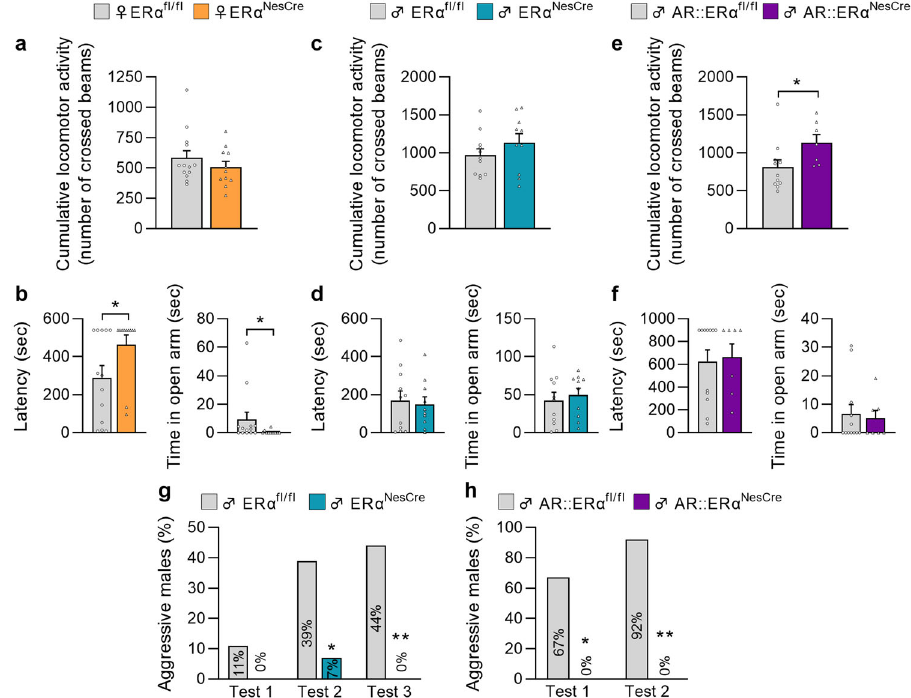
Fig. 6 Effect of neural ER α or AR :: ER α deletion on locomotor activity, anxiety-related, and aggressive behavior. a , c , e Cumulative locomotor activity recorded in a circular corridor during the 2 h-test for control (ER α fl / fl ) and mutant (ER α NesCre ) females ( a , n = 11 – 13 per genotype), control (ER α fl / fl ) and mutant (ER α NesCre ) males ( c , n = 10 – 11 per genotype), or control (AR::ER α fl / fl ) and mutant (AR::ER α NesCre ) males ( e , n = 7 – 11 per genotype). b , d , f Anxiety-related behavior measured in the elevated O-maze for control (ER α fl / fl ) and mutant (ER α NesCre ) females ( b , n = 11 – 13 per genotype), control (ER α fl / fl ), and mutant (ER α NesCre ) males ( d , n = 10-11 per genotype), or control (AR::ER α fl / fl ) and mutant (AR::ER α NesCre ) males ( f , n = 7-11 per genotype). The latency to enter the open arm (left) and the time spent in the open arm (right) were analyzed. g , h Percentage of males from the ER NesCre ( g ) or AR::ER α NesCre ( h ) mouse lines displaying aggressive behavior towards non-aggressive males in the resident-intruder test across two or three tests. * p < 0.05, ** p < 0.01 versus the control group. Data are shown as means± S.E.M. with individual values (panels a – f ) or as percentage (panels g , h ER α NesCre males, which were castrated and supplemented with equivalent testosterone concentrations (Supplementary Fig- ure 2a). In contrast, a higher locomotor activity ( + 44%) was